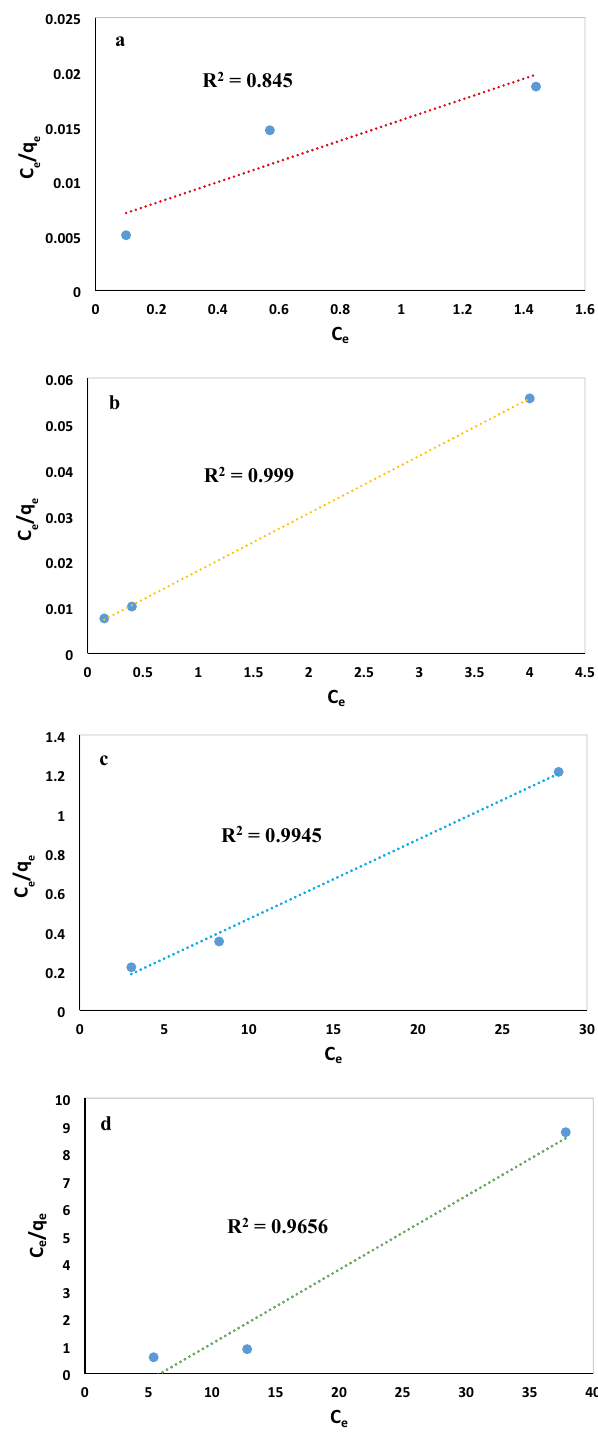
Figure 11. Langmuir isotherm fitting for ( a ) MR, ( b ) MO, ( c ) MB, ( d ) MG on